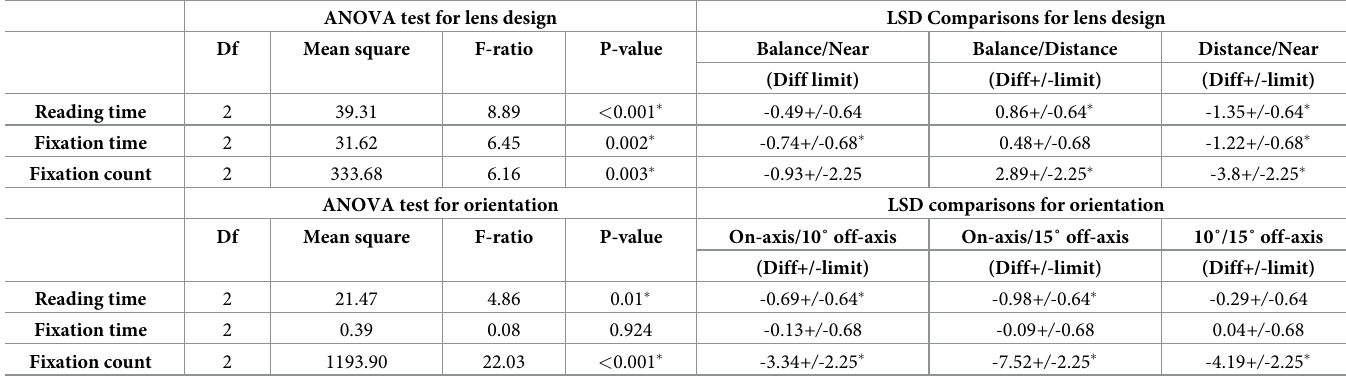
Table 2. Detailed statistics for Fig